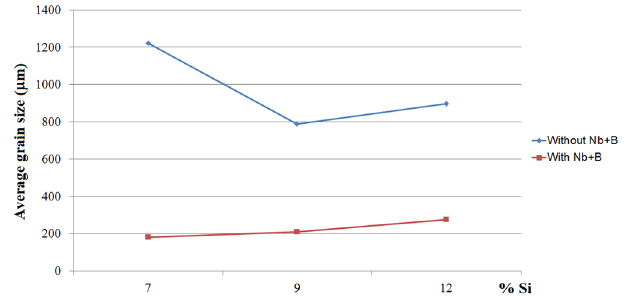
Figure 3. Comparison of the average variation in the primary α-Al grain size with the silicon content, without and with Nb + B. (Microsoft Excel 2010).